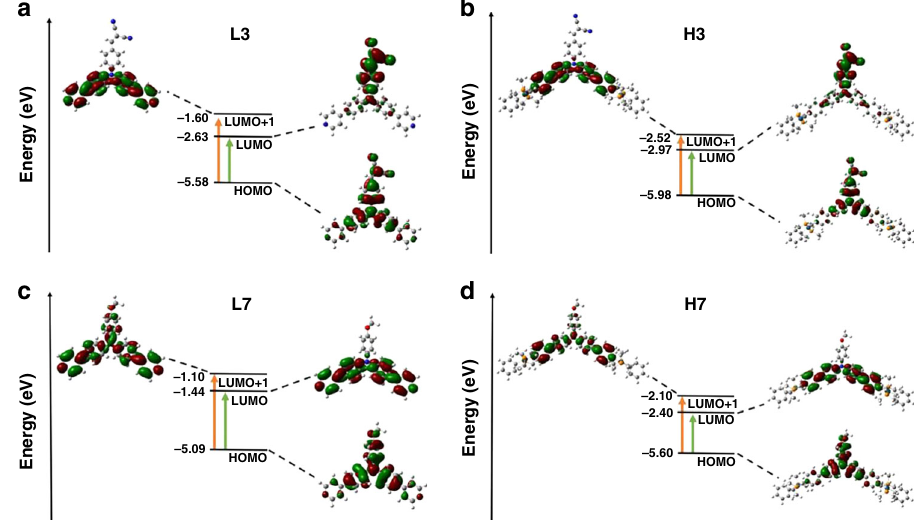
Fig. 7 TD-DFT transitions for L3 , L7 , H3 , and H7 . Predicted TD-DFT transitions for ligands L3 a , L7 c , and metallacycles H3 b , H7 d model with oscillator strengths above